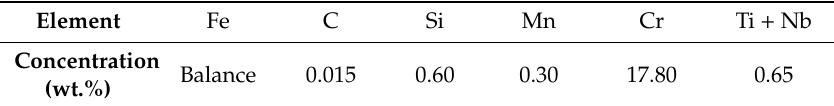
Table 1. Nominal composition of AISI